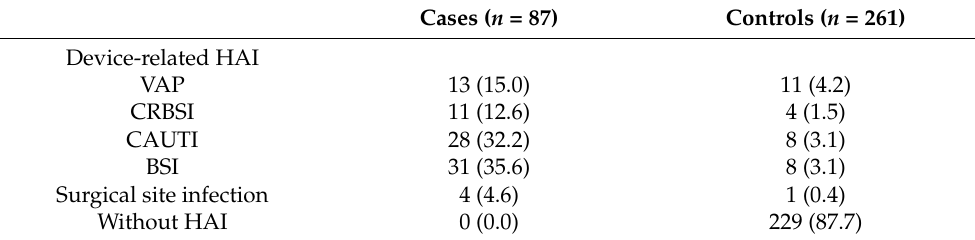
Table 3. Types of healthcare-associated infections (HAIs) registered by the active surveillance system among the cases and controls. Infections among the cases are sustained by multidrug-resistant Klebsiella pneumoniae , while infections among the controls are sustained by microorganisms other than multidrug-resistant Klebsiella pneumoniae. Results are expressed as numbers